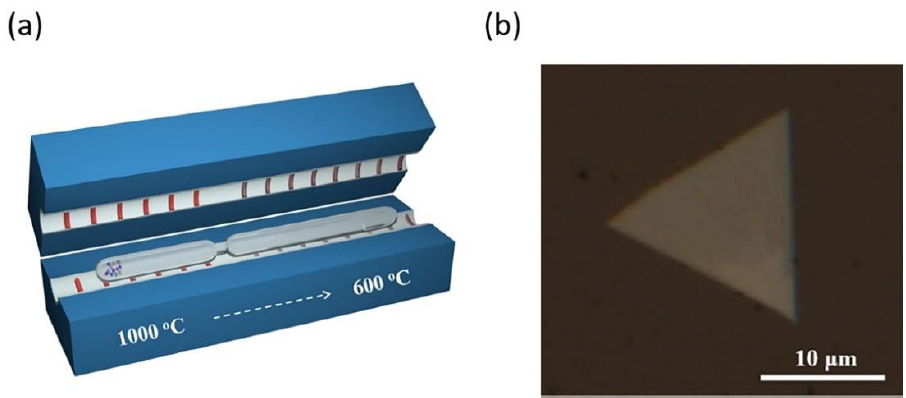
Figure 10. ( a ) A Schematic for the set-up of CVT growth of ReSe2 flakes. The end of ampoule with the source materials and transport agents is placed at the high temperature zone and the other end is placed at the low temperature zone. ( b ) Optical image of a typical CVT-grown ReSe2 flake on mica substrate. Reprinted under the terms of a Creative Commons Attribution 4.0 International License from ref. [ 99 ] . Copyright 2019 John Wiley and Sons.